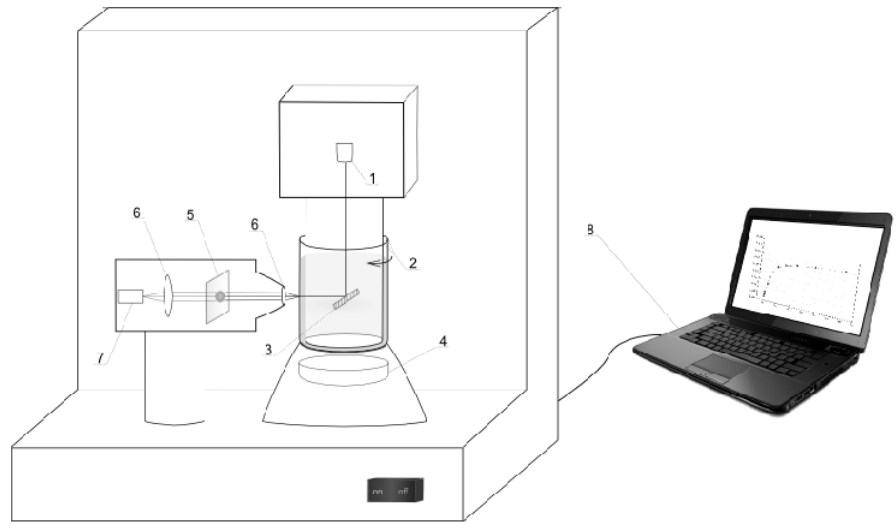
Fig. 1. Schematic layout of the di®ractometer-ektacytometer: 1 — diode laser, 2 — Couette chamber, 3 — mirror, 4 — step